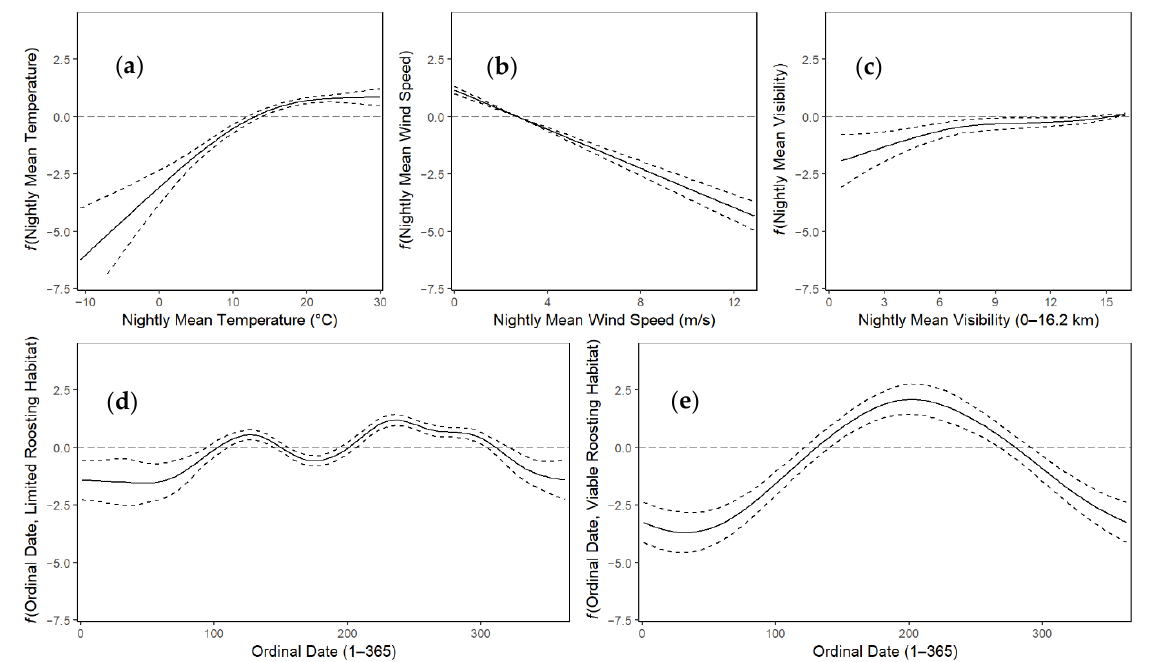
Figure 5. Visualizations of all smooth effect components, f ( x ), of the final model which was fit using acoustic data off the Eastern Shore of Virginia, USA, 2012–2019. The fits (solid lines) and 95% confidence intervals for the fits (black dotted lines) are displayed. Smooths, f ( x ), can be interpreted as the effect of the variable, x . Nightly occurrence probability is positively associated with larger smooth values along the range the of variable. These smooth components, f ( x ), are on the logit scale, for example, the dotted line at 0 on the logit scale indicates 50% probability of occupancy. The final model used smooth effects of nightly means of temperature ( a ), wind speed ( b ) visibility ( c ), and the ordinal date ( c ). The shape of the smooth effect was separated by roost availability, by limited ( d ), or viable ( e ). Table 5. Beta parameters names, estimates, standard errors, and p -values for site-specific intercept